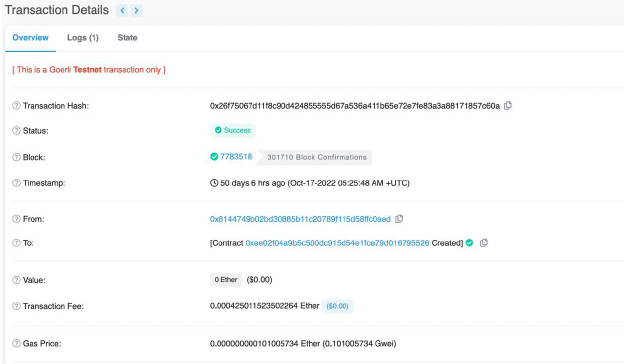
Figure A2. Proof of deploying smart contracts on Etherscan.